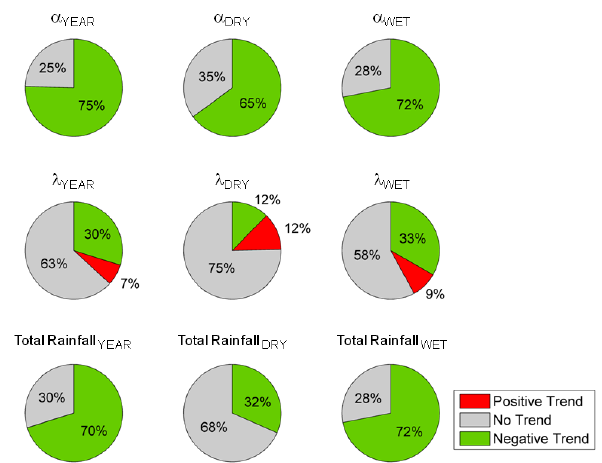
Fig. 7. Daily rainfall analysis: percentage of stations showing neg- ative, positive or no significant trend in average rainfall intensity Figure 7. Daily rainfall analysis: percentage of stations showing negative, positive or no 3 (first row), frequency (second row) and in total rainfall. Columns significant trend in average rainfall intensity (first row), frequency (second row) and in total 4 present annual (first), dry (second) and wet (third) period rainfall. Columns present annual (first), dry (second) and wet (third) period results. 5